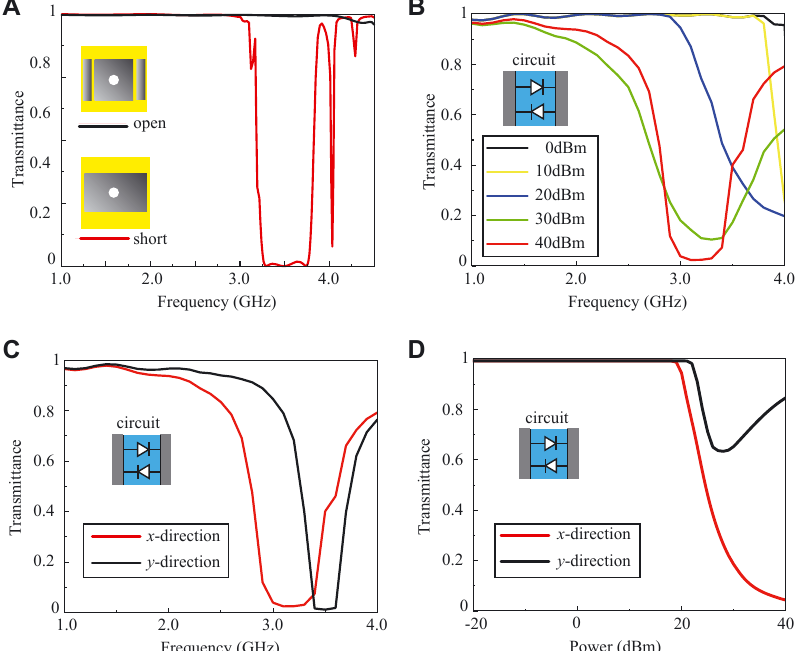
Figure 6: Surface wave propagation along the x direction (as in Figure 5A) with (A) open/short unit cells and (B) open unit cells connected by pairs of diodes at various power levels. (C) Validation of anisotropic surface impedance. Surface waves are set to propagate along the x direction or the y direction (as in Figure 5B) at 40 dBm. (D) Power dependency of the surface wave propagation along the x and y directions at 3 GHz. The input power is swept in 1 dBm steps.